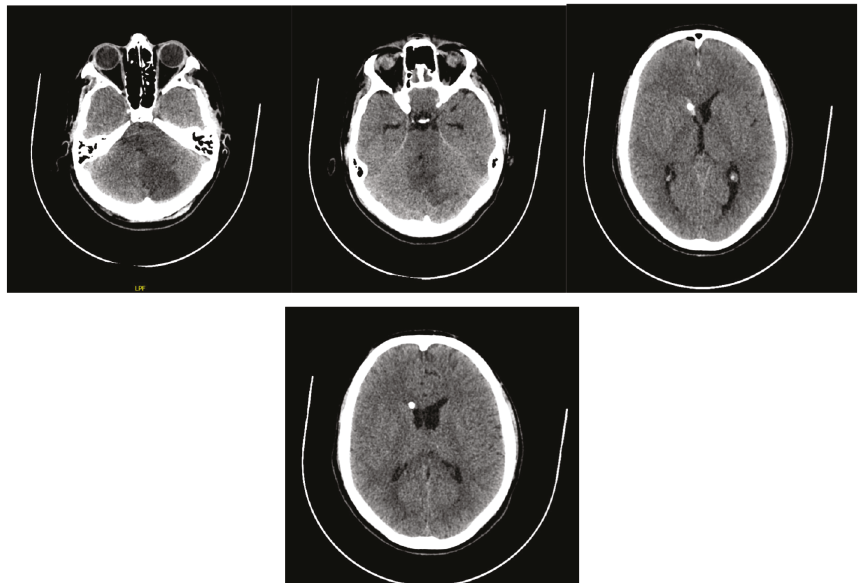
Figure 4: Simple control computed tomography of the skull. (a). Established infarction in the left cerebellar hemisphere. (b). Ventricular and cisternal systems with normal shape, size, and position. (c). A ventricular bypass catheter enters through the right frontal region, with the distal end in the frontal horn of the right lateral ventricle. (d). Decrease in size of the right ventricular system compared with the contralateral